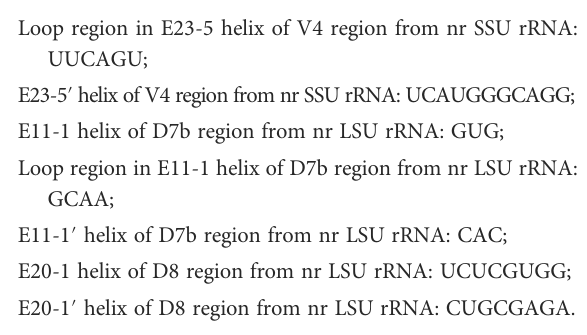
HOLOTYPE: NNIBRPR 25449, a permanent microscope slide